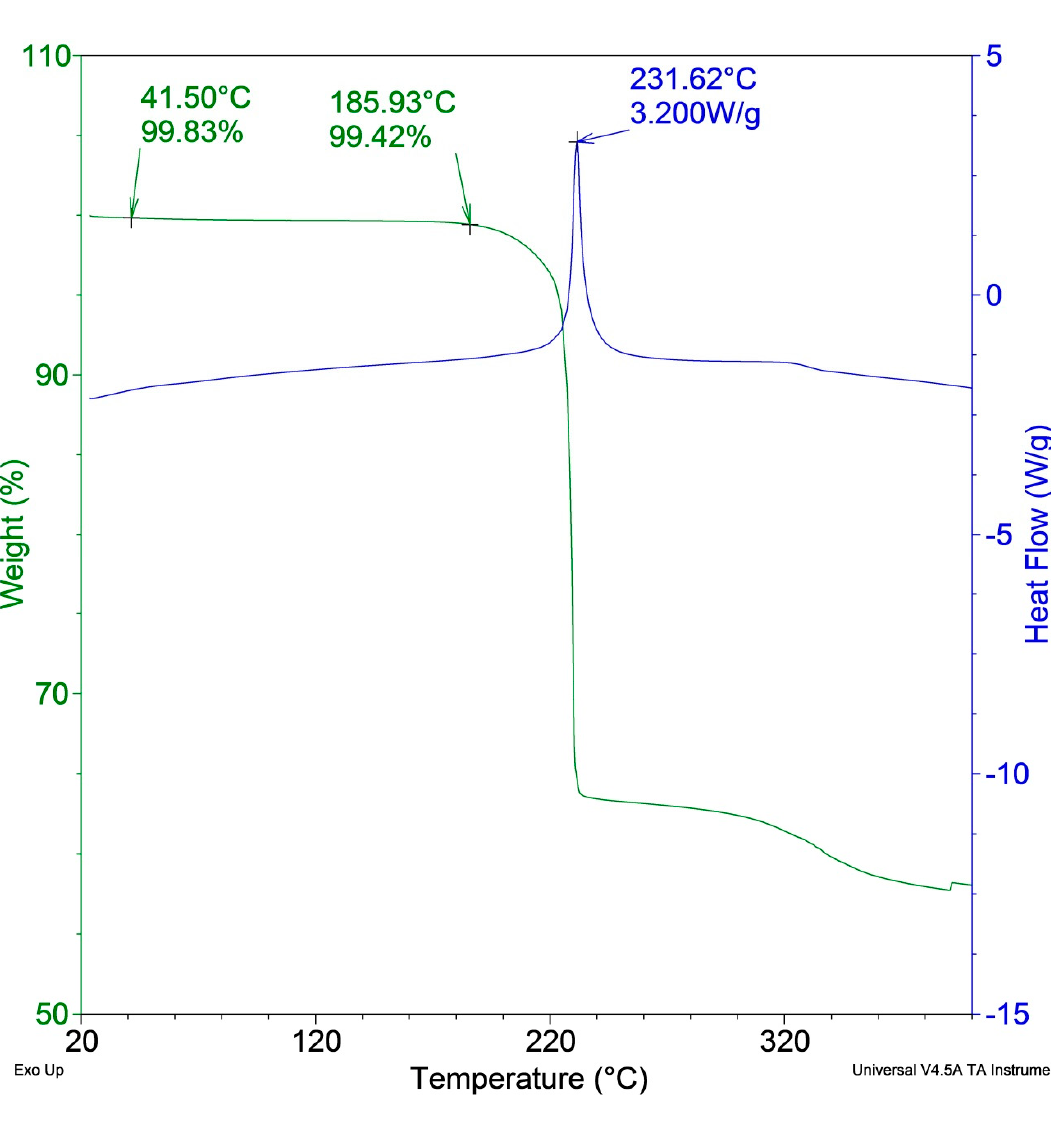
Figure 3. The TG / DSC traces (low-temperature fragments) for pure Ag(BTCO) complex demonstrating Figure 3. The TG/DSC traces (low-temperature fragments) for pure Ag(BTCO) complex its thermal stability up to ~180 ◦ demonstrating its thermal stability up to ~180 °C.